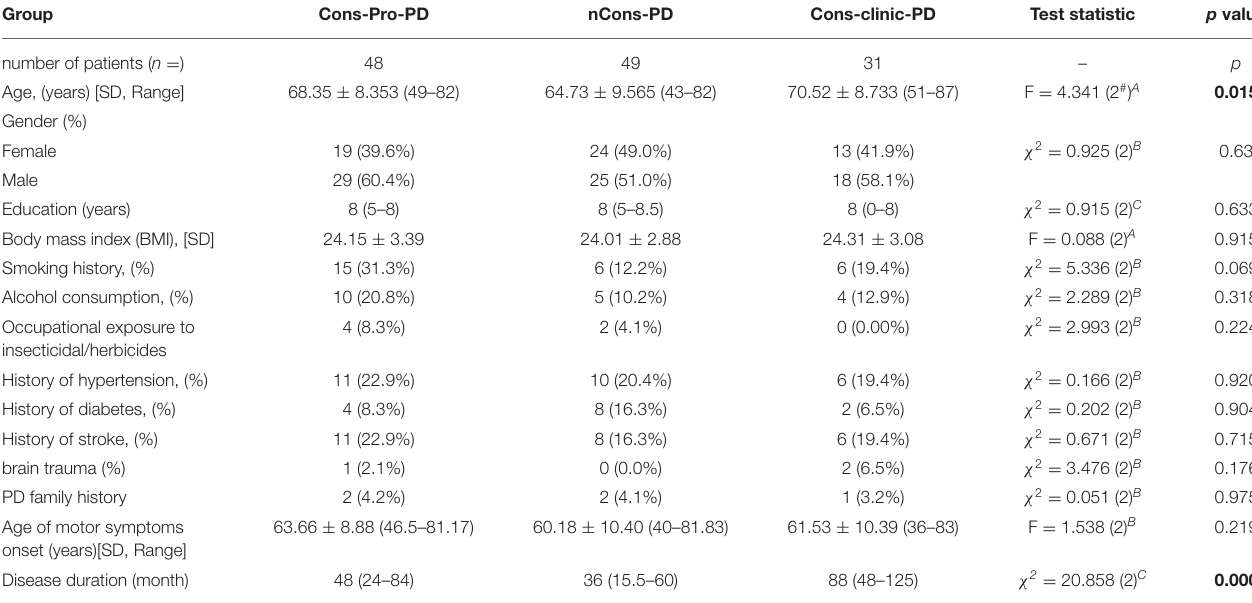
TABLE 1 | Demographic characteristics of the subjects in the study.